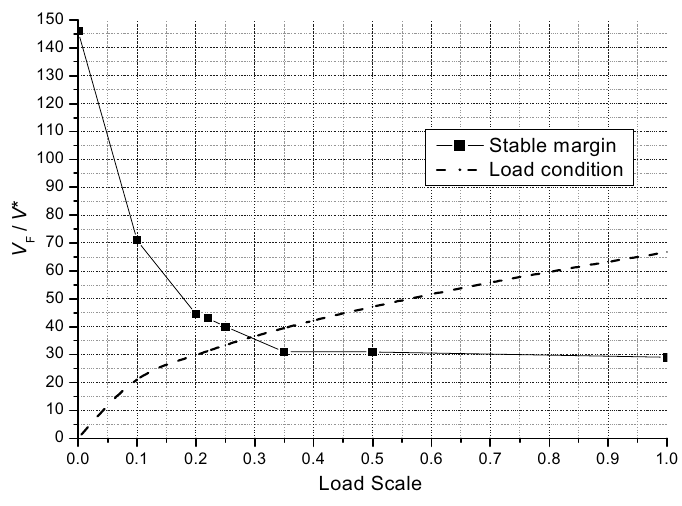
Fig. 3. Locus of flutter speed versus load